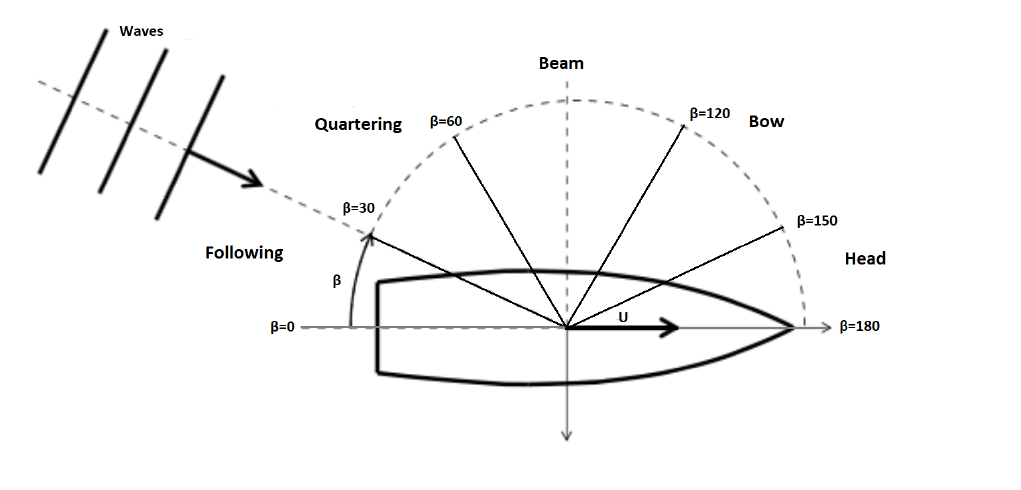
Figure 7. The relation of encounter angles β for different sea